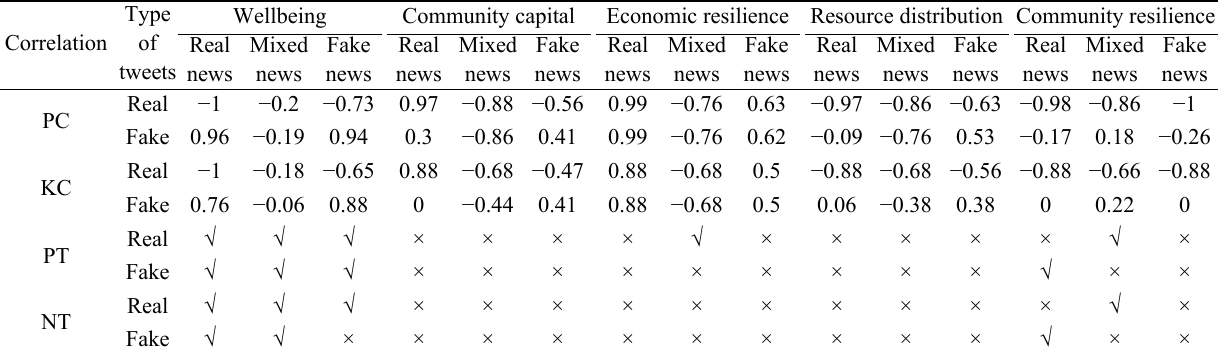
Table 11 Statistical analysis of various functionalities for three news compared to two types of tweets: pearson correlation